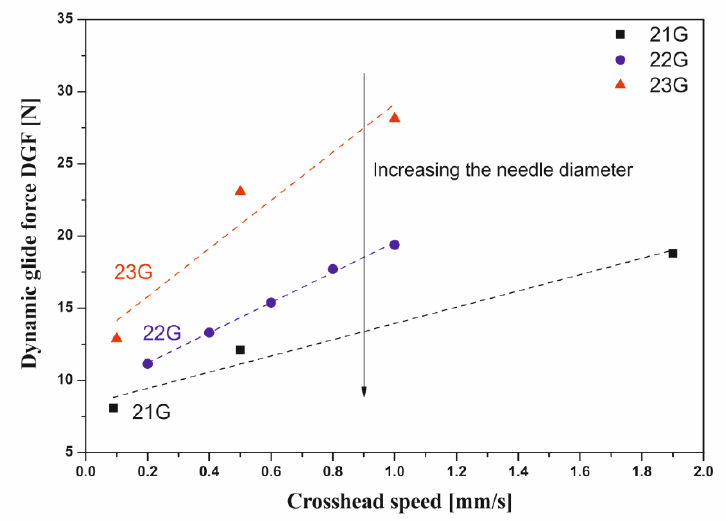
Figure 4. Influence of the crosshead speed on the value of the dynamic glide force (DGF) for needles 21G, 22G, and 23G.